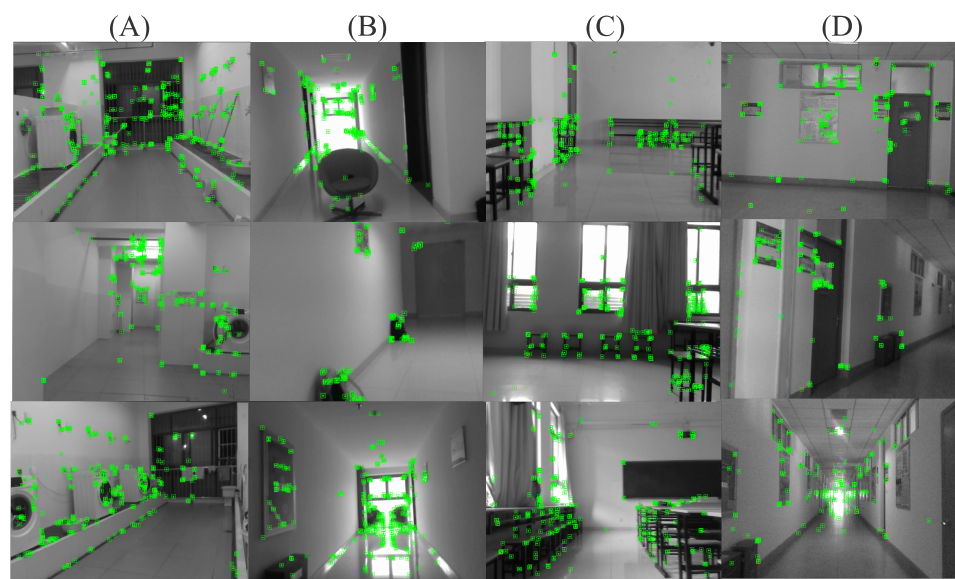
Figure 7. Example of the feature points extraction for ( A ) the washing machine and other objects in U-shaped hallway scene; ( B ) the obstacles in H-shaped hallway scene; ( C ) the seats and desks in the Loop-shaped hallway scene; ( D ) the walls in T-shaped hallway